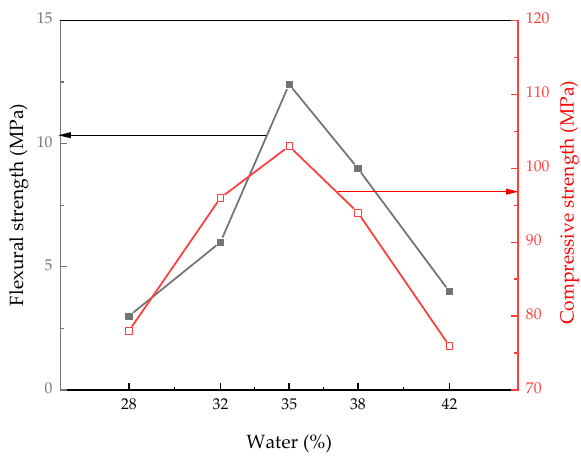
Figure 9. The mechanical strengths of alkali-activated BFS with different potassium